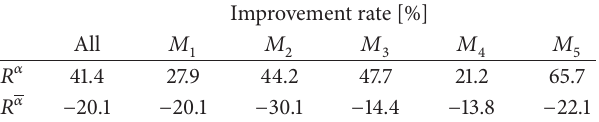
Table 4: Improvement rate (Experiment 2